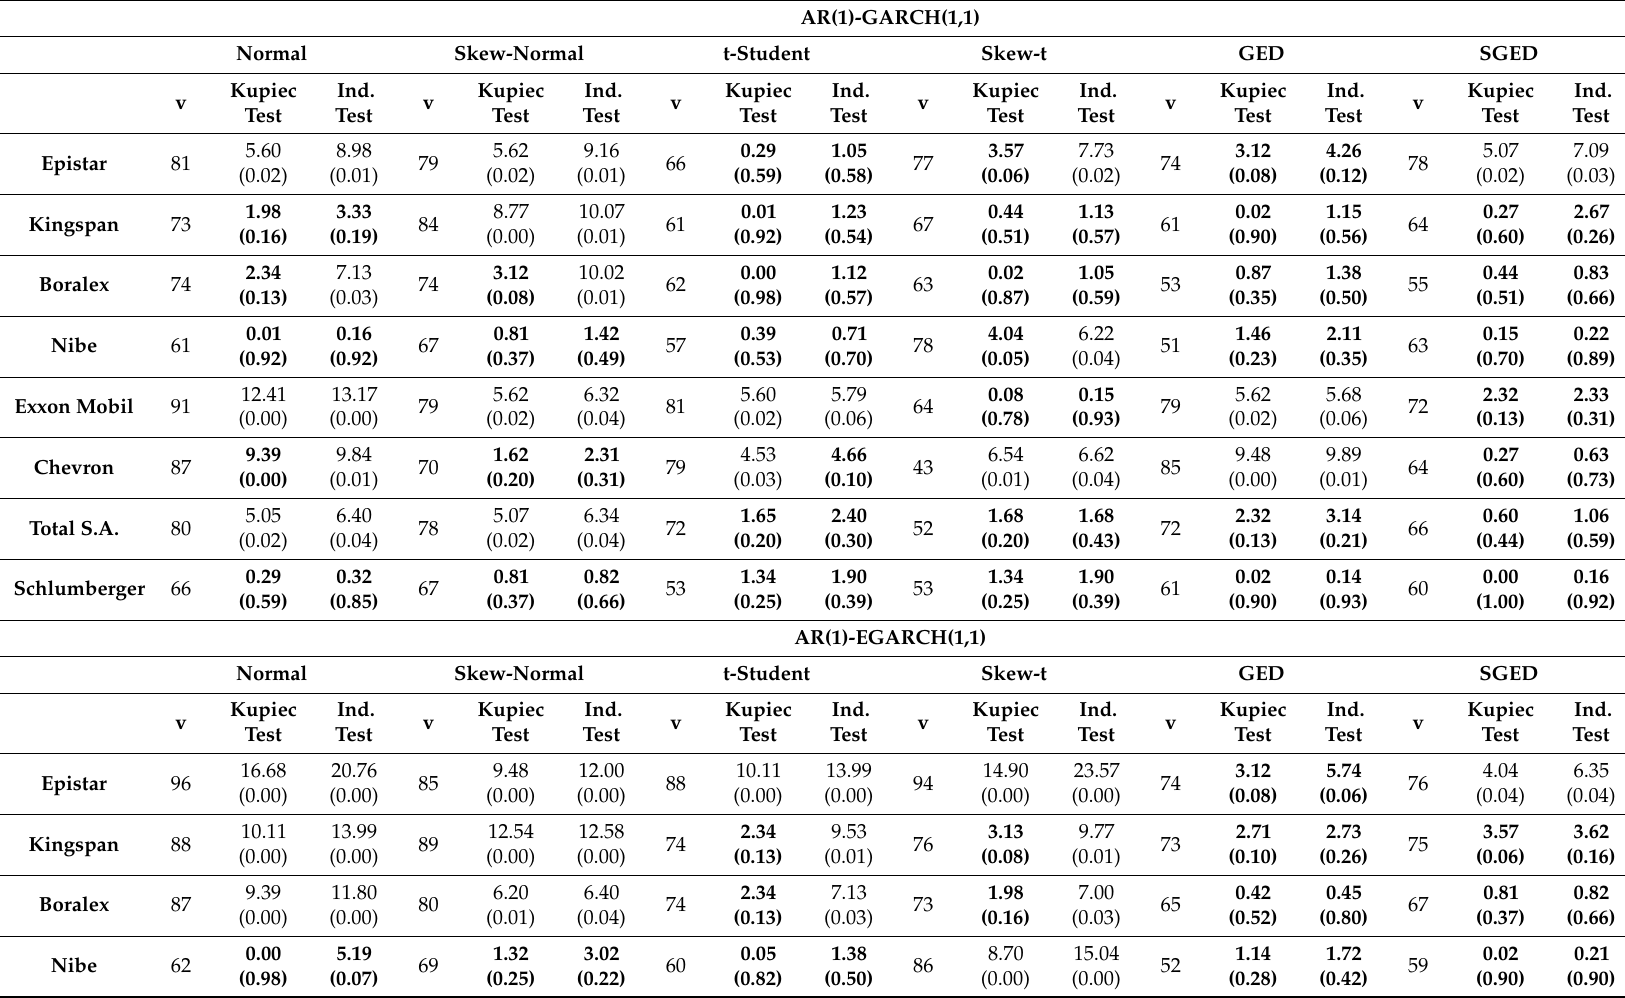
Table 4. 97.5%-VaR backtesting. Expected violations (EV) =